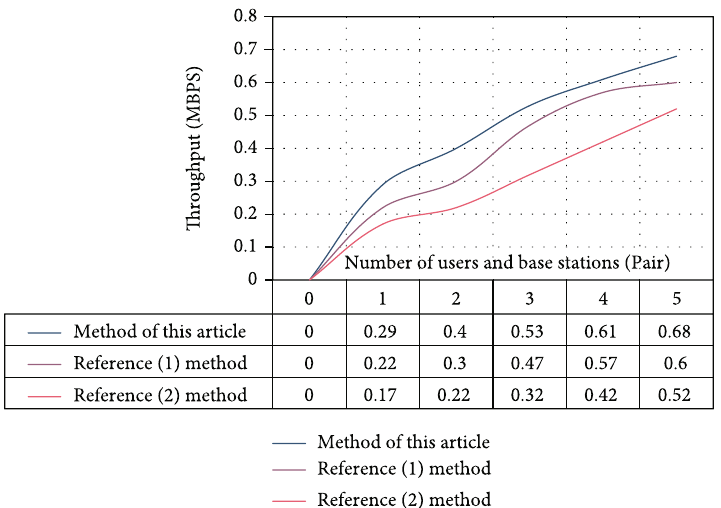
Figure 3: Comparison of throughput of di ff erent algorithms.